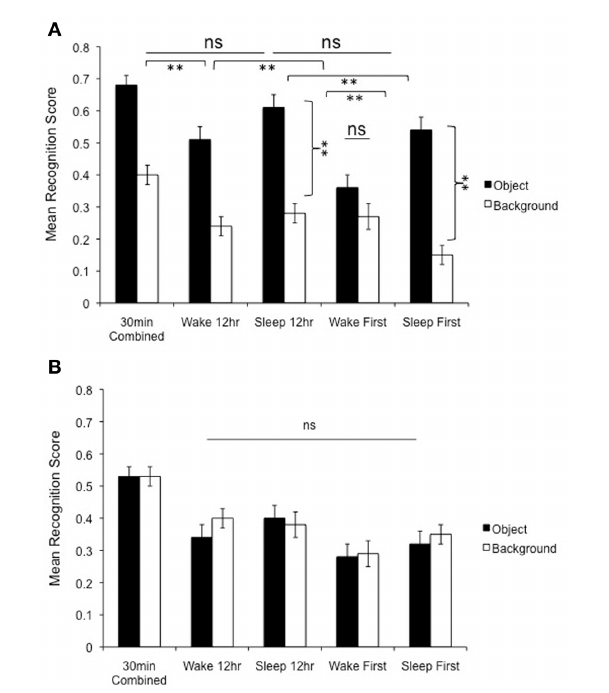
FIGURE 6 | (A) Change in memory across time. Relative to the 30min condition, negative object memory was preserved 12h later provided that subjects slept in the delay interval (Sleep 12h group). Moreover, there was no further deterioration in negative object memory over the next 12h (comparison between the Sleep 12 and 24h Sleep First group). However, the backgrounds associated with these negative objects continued to deteriorate across these delay intervals, suggesting that sleeping soon after learning is key for protecting memory for emotional components of scenes. In the wake groups, on the other hand, memory for negative objects continued to deteriorate from the 30min to Wake 12h and from Wake 12 to 24h Wake First delays, which depicts a pattern of increasing memory deterioration for negative objects in the wake groups. Note also the absence of the trade-off effect in the 24h Wake First group (no difference in memory for objects vs. backgrounds), as well as the increased magnitude of the trade-off effect in the two sleep conditions (sleep 12 and 24h Sleep First—see brackets). ∗∗ p < 0 . 01. (B) Memory for neutral scenes shows a net decline over time, but note that the groups groups do not differ in memory for objects vs. backgrounds at any of the delay